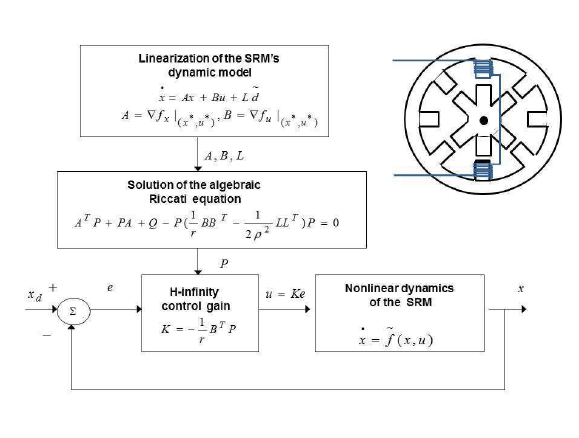
Fig. 2: Diagram of the control scheme for the switched reluctance machine